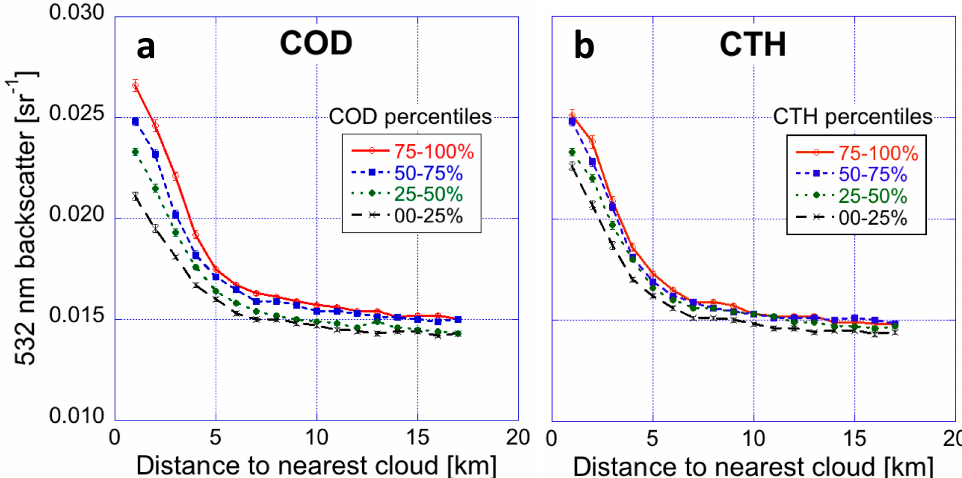
Figure 5. Mean vertically integrated backscatter, plotted for oceanic areas as a function of distance to the nearest clouds. ( a ) The dataset is split into 4 quartiles based on the maximum cloud optical depth (COD) of nearby clouds (Data used are available at Table S6); ( b ) The dataset is split into 4 quartiles based on the maximum cloud top height (CTH) of nearby clouds (Data used are available at Table S7).